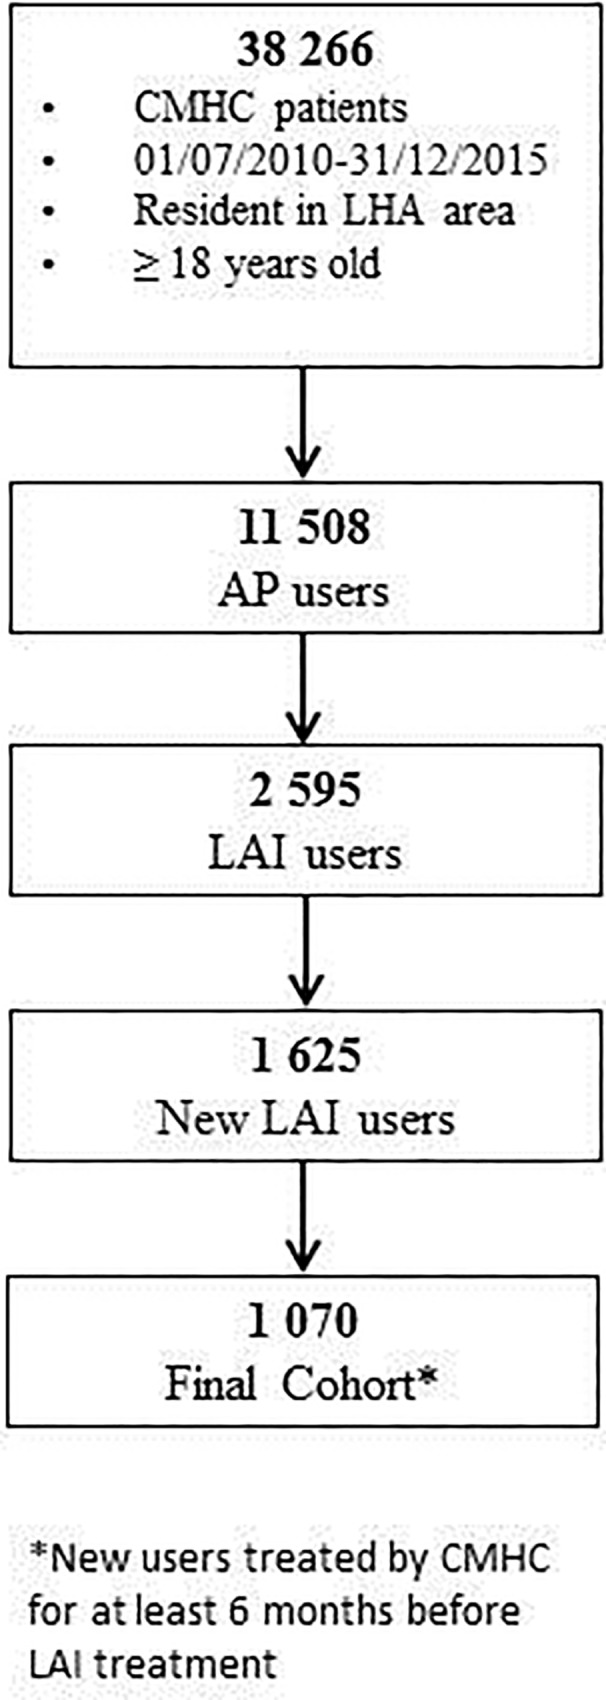
Flow chart of cohort selection.